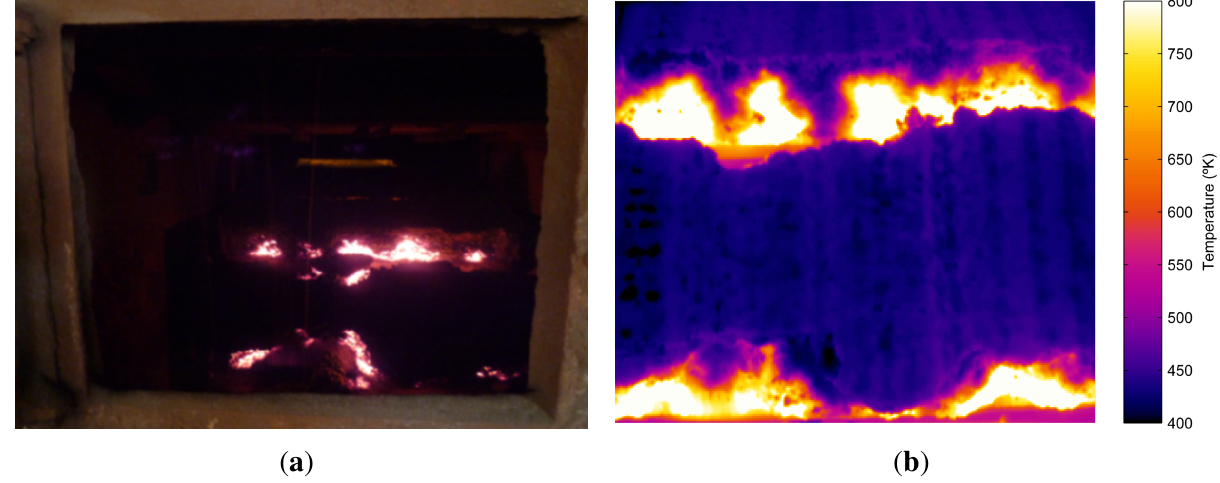
Figure 3. Discharge end of the sintering process. ( a ) Image taken in the visible spectrum; ( b ) infrared image.